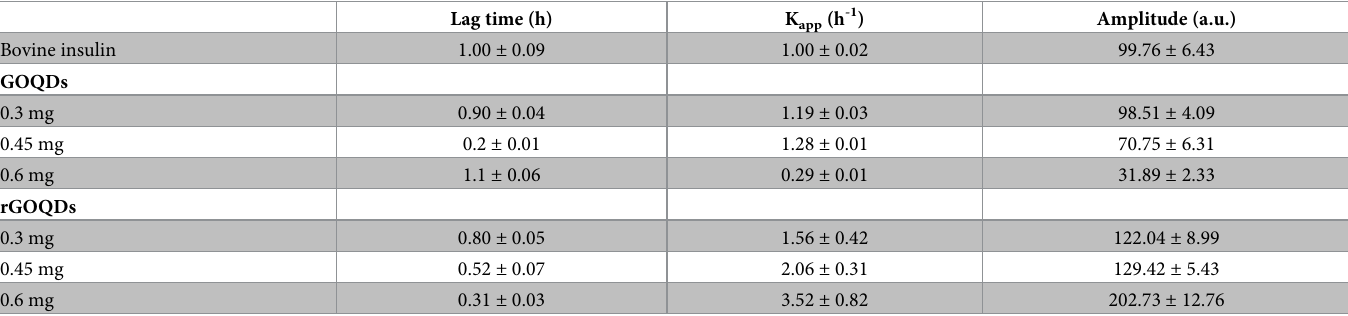
Table 1. Effect of GOQDs/rGOQDs on the kinetics parameters of bovine insulin fibrillization determined by ThT fluorescence